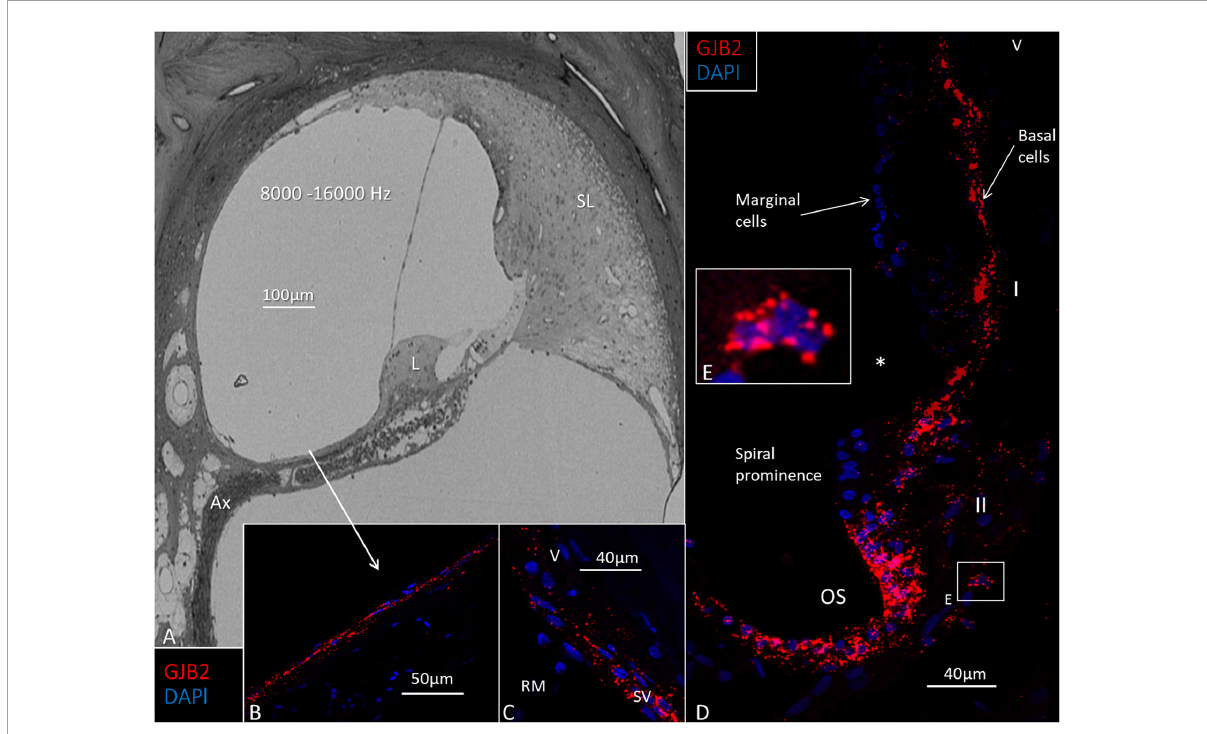
FIGURE6 Light microscopy and GJB2 in the basal turn of the cochlea at the high frequency region 8000–16000 Hz). (A) The spiral limbus (L) and tectorial membrane near the round window are smaller at this location, and the spiral ligament (SL) is more voluminous. Ax: peripheral axons. (B) GJB2 gene transcripts in mesothelial cells lining the floor of the scala vestibuli. (C) GJB2 gene transcripts at the lateral insertion of the Reissner’s membrane (RM). SV: stria vascularis. V: type V fibrocytes. (D) A large number of GJB2 gene transcripts in the basal cells extend from the RM to the spiral prominence. *: disrupted marginal cells. The outer sulcus (OS) contains many GJB2 gene transcripts. (E) Magnification of the framed area in (D) shows a type II fibrocyte rich in GJB2 transcripts. I, II: fibrocytes types I and